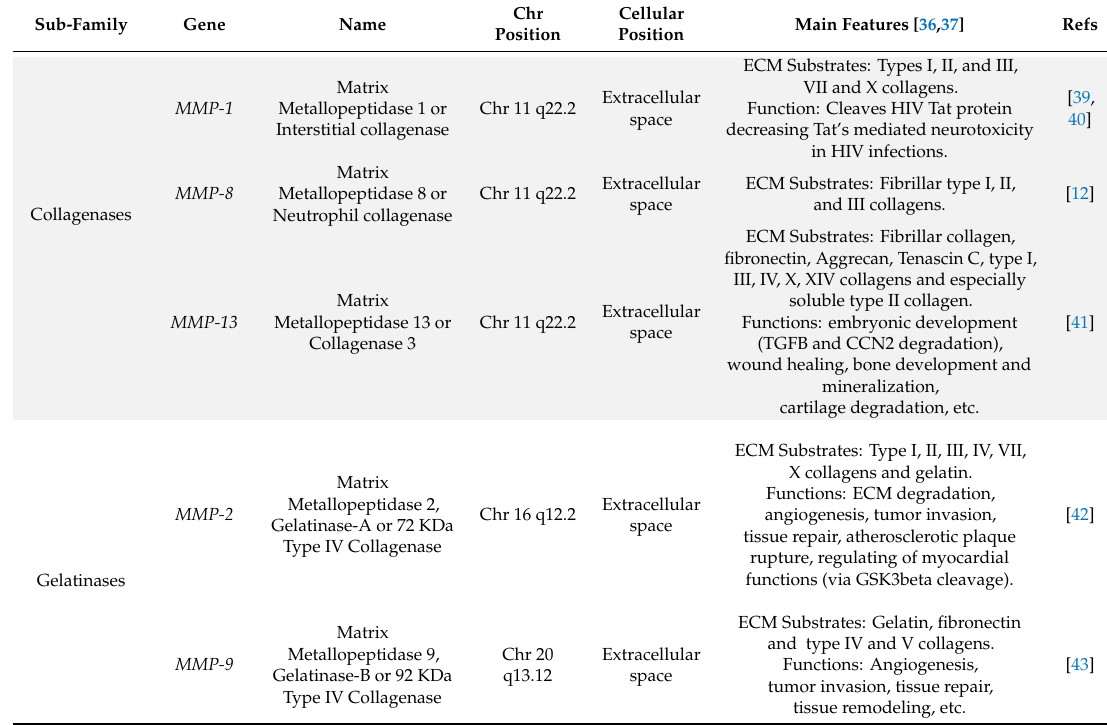
Table 1. Classification of the MMP family